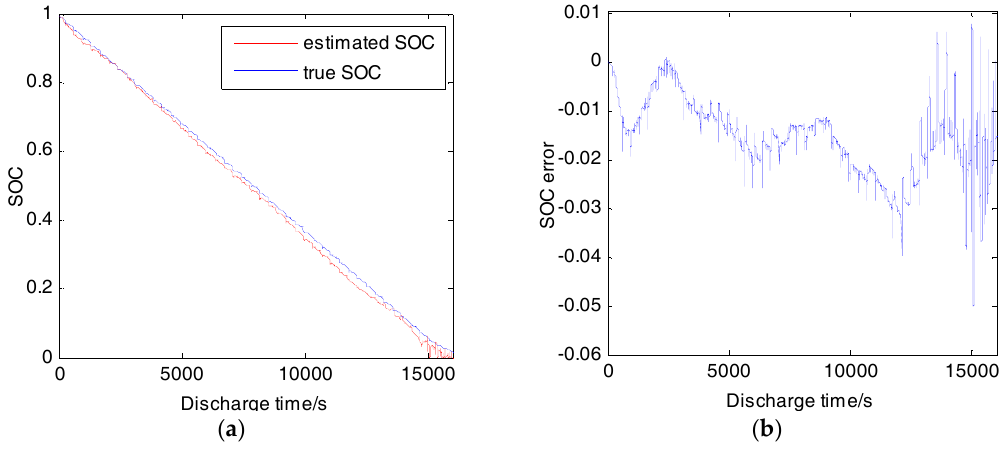
Figure 14. SOC estimation result (DST, 20 °C): ( a ) Estimated SOC and true SOC; ( b ) SOC estimation error.